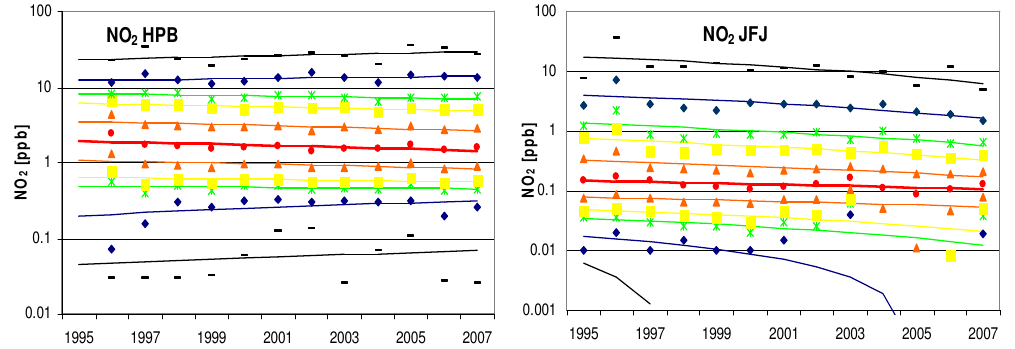
Fig. 13. NO 2 time series of annual percentiles and respective linear trends at the “DACH” sites since 1995; black: minimum and maximum, blue: 1- /99- ; green: 5- /95- , yellow: 10- /90- ; orange: 25- /75-percentiles, red: median.